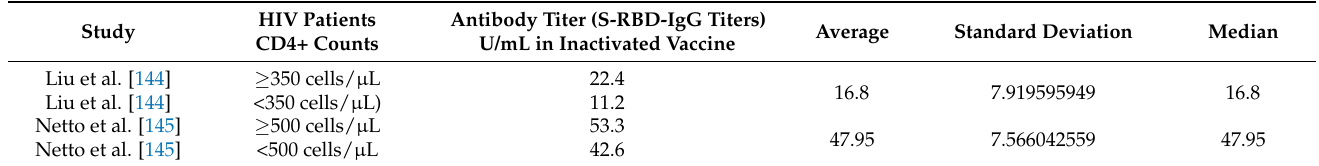
Table 6. Beneficial immune responses in HIV patients after taking COVID-19 vaccine.